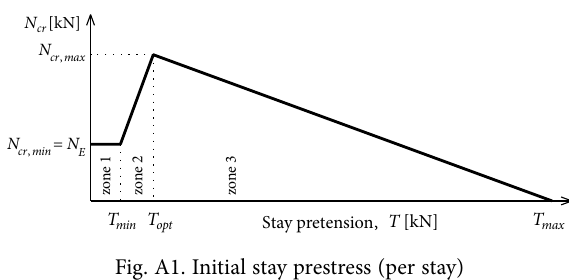
are the column axial and bending stiffness.